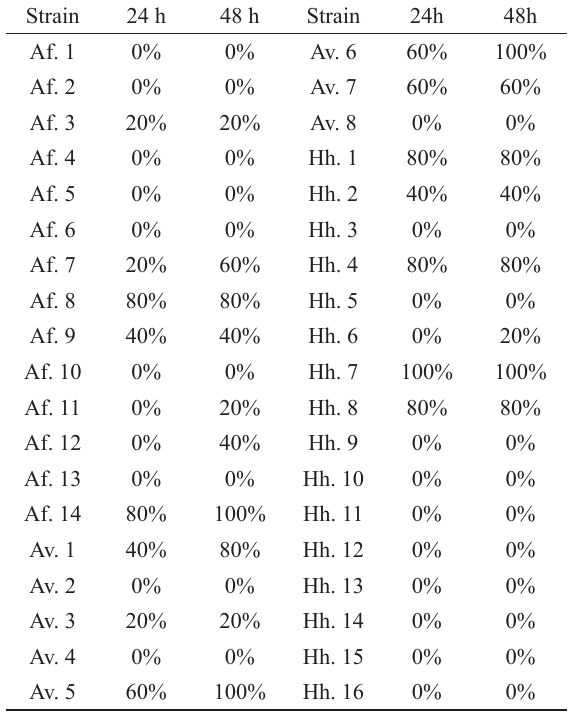
Values of Emulsification index for the bacterial isolates from the sponges